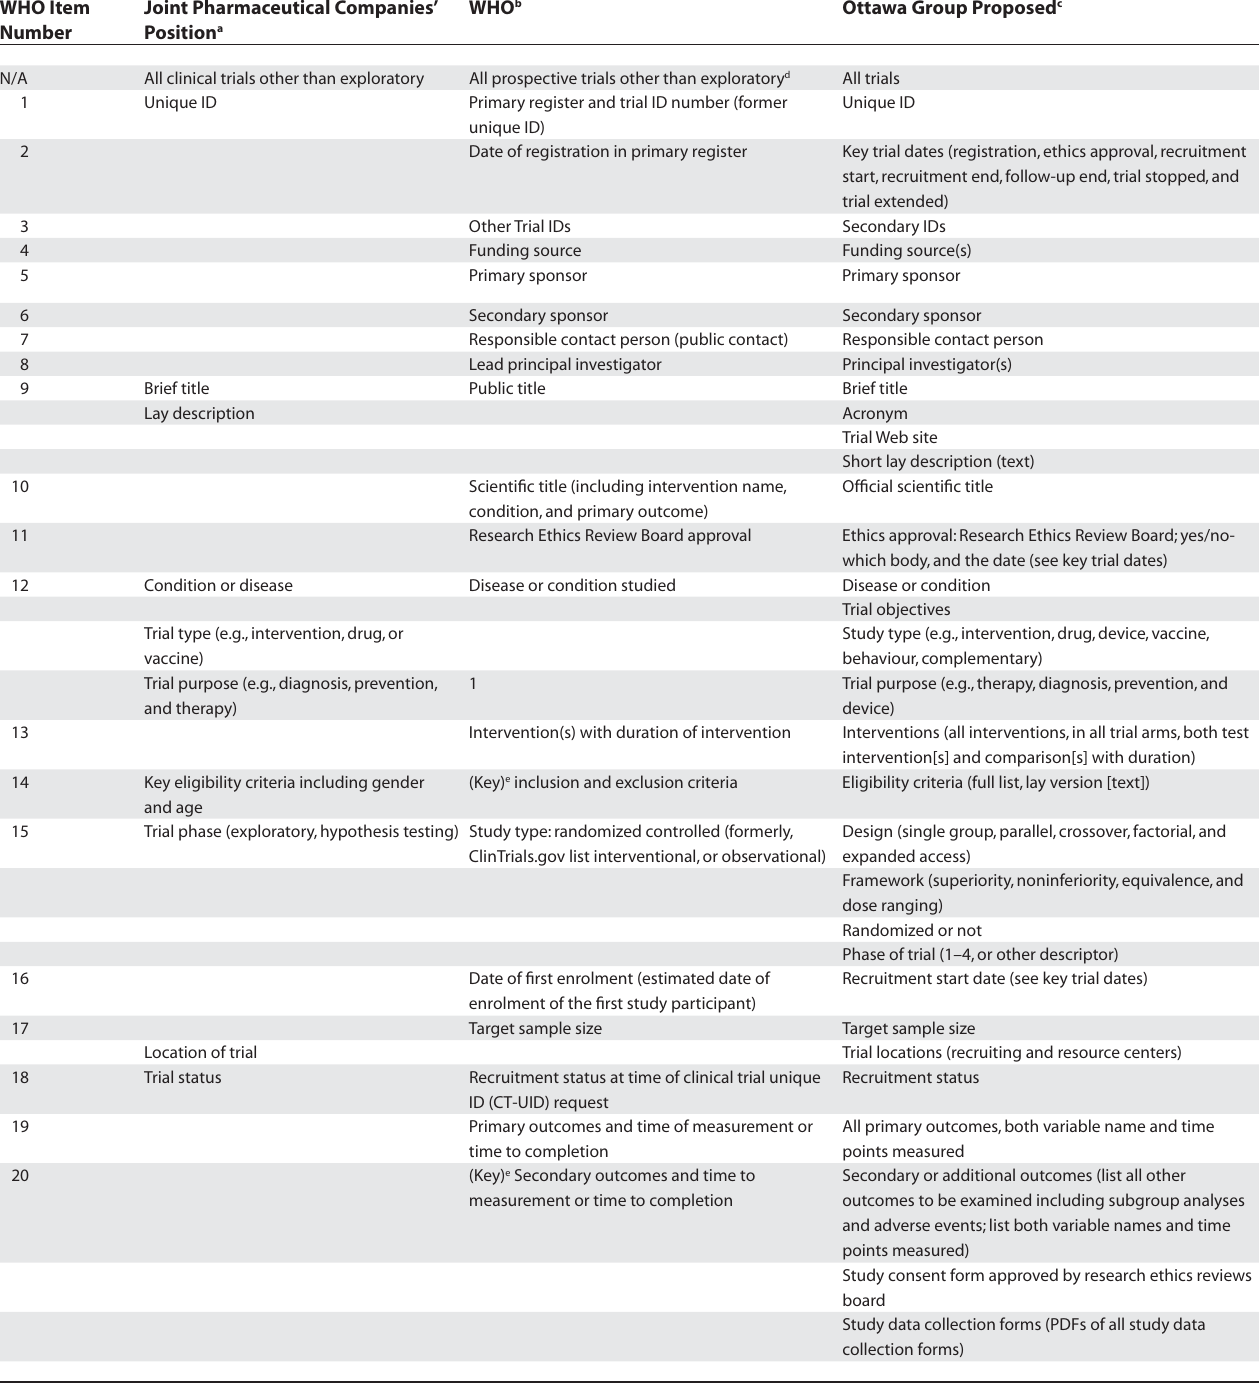
Table 1. Comparison of Trial Registration Protocol Items Proposed by the Pharmaceutical Industry, the WHO, and the Ottawa Group WHO Item Joint Pharmaceutical Companies’ WHO b Ottawa Group Proposed c Number Position a All clinical trials other than